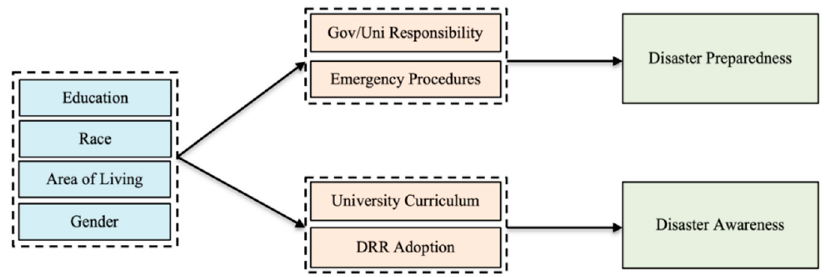
Figure 5. Verified Model After the Analysis.